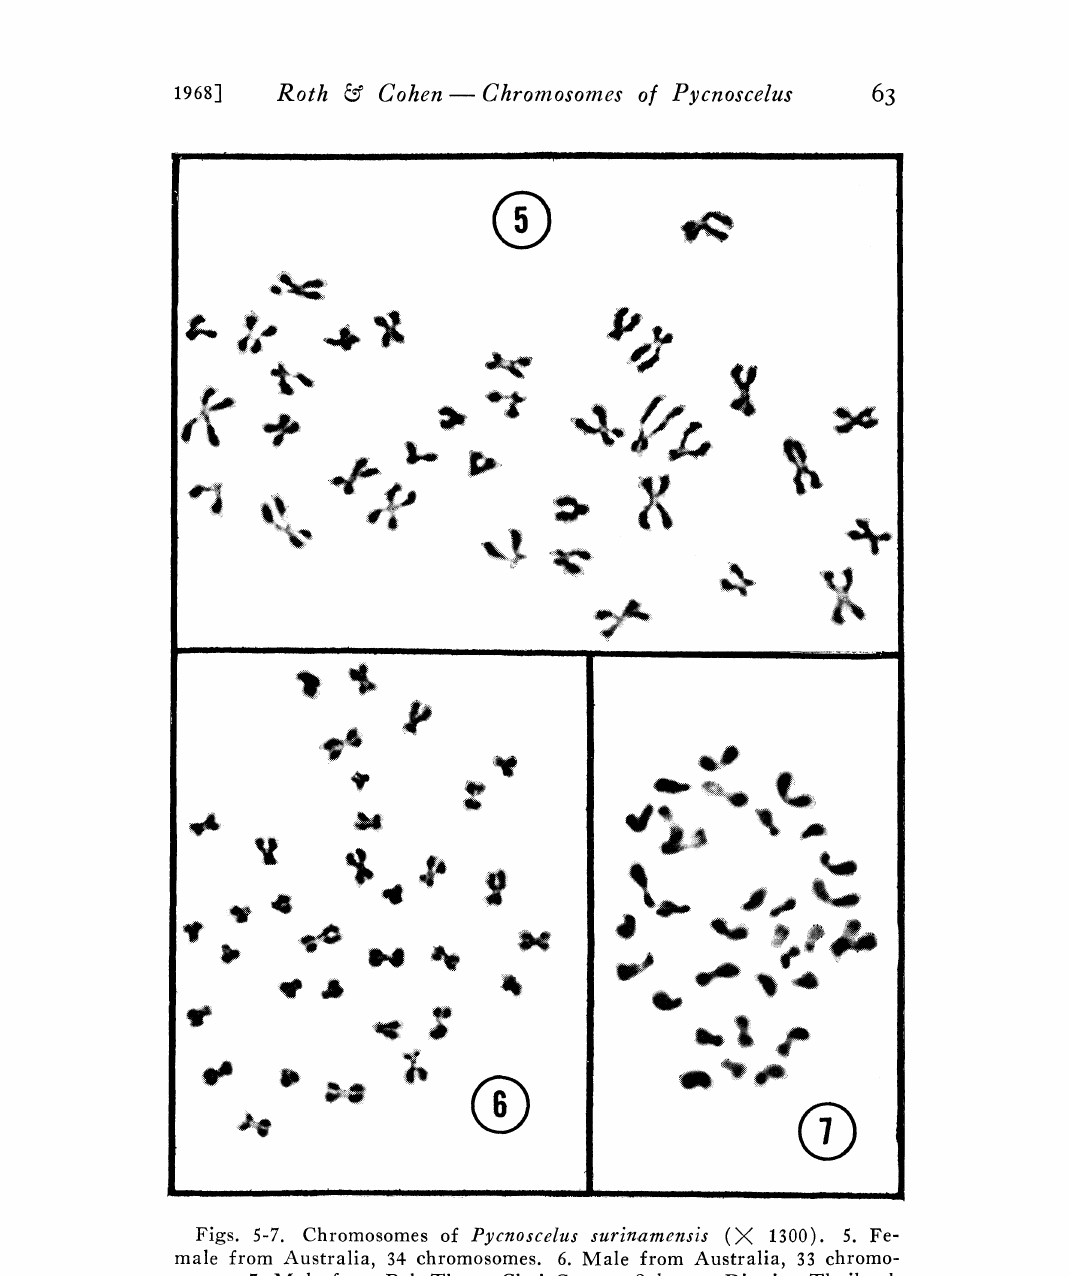
Figs. 5-7. Chromosomes of Pycnoscelus surin.amensis (X 1300). 5. Fe- male from Australia, 34 chromosomes. 6. Male from Australia, 33 chromo- somes. 7. Male from Pak Thong Chai County, Sakaerat District, Thailand, 33